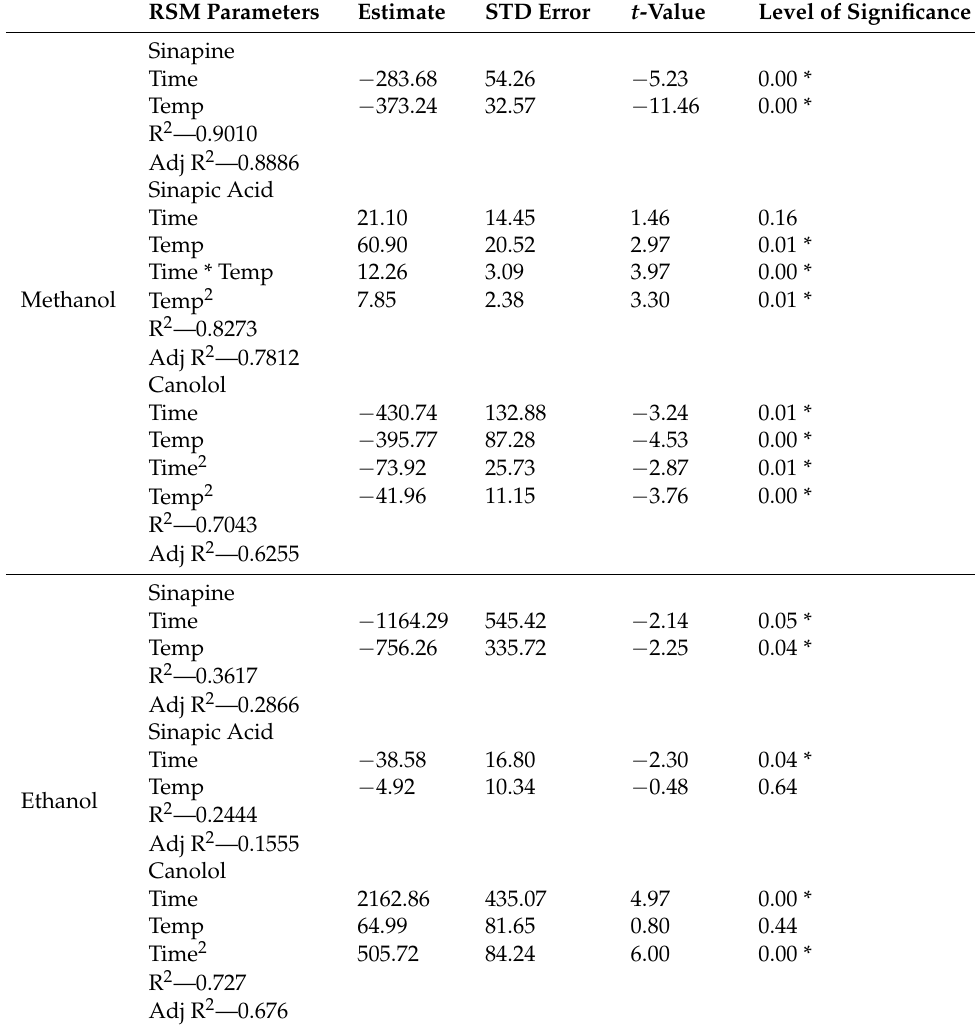
Table 2. Response surface analysis of optimized conditions for major